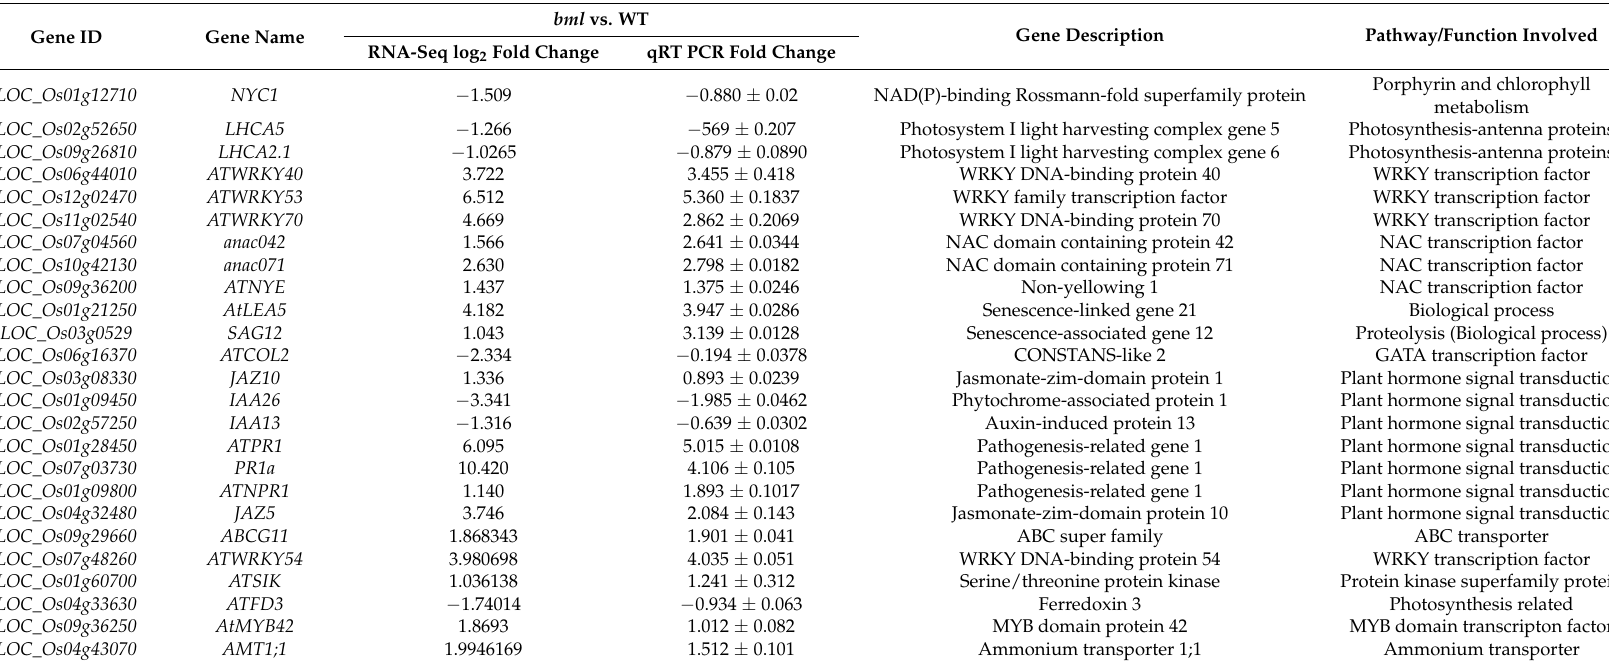
Table 3. Relative expression of 25 randomly-selected genes for comparison between the bml mutant and WT group with respect to RNA- seq and qRT PCR. Gene